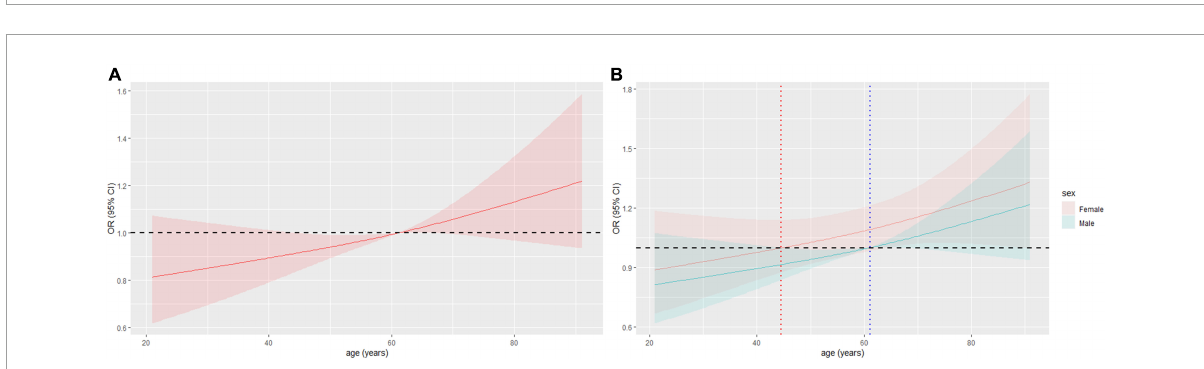
FIGURE6 Restricted cubic spline (RCS) of age and AF in all patients after PSM. (A) RCS of age and AF. (B) RCS of age and AF in different sex, OR = 1 when age = 44.6 years or 61.1 years in female or male, respectively. AF, atrial fibrillation; OR, odd ratio; PSM, propensity score matching.